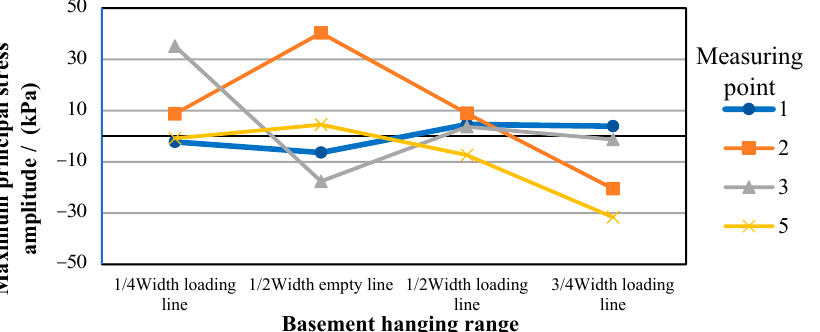
Figure 17. Maximum principal stress amplitude diagram of measuring points 1, 2, 3, and 5 under different basement hanging ranges. Table 15. Maximum principal stress amplitude of measuring points 1, 2, 3, and 5 under different basement hanging ranges.